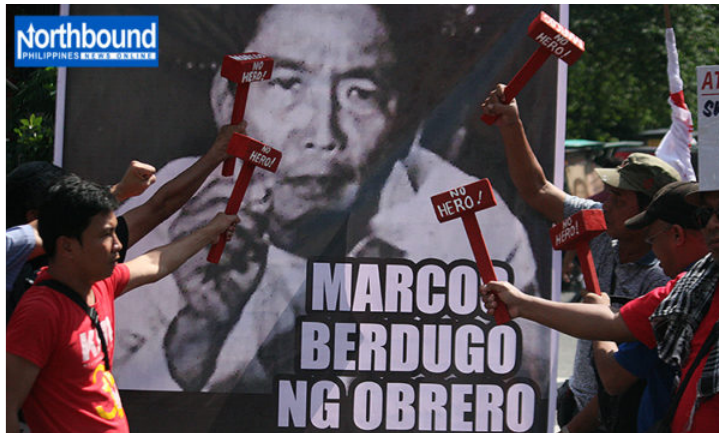
Figure 5. Bilingual protest sign. A poster of Marcos is hit by a group of laborers with their ‘Marcos no hero” mallets. The poster reads “Marcos is an executioner of laborers” in a mix of Tagalog and Spanish words.